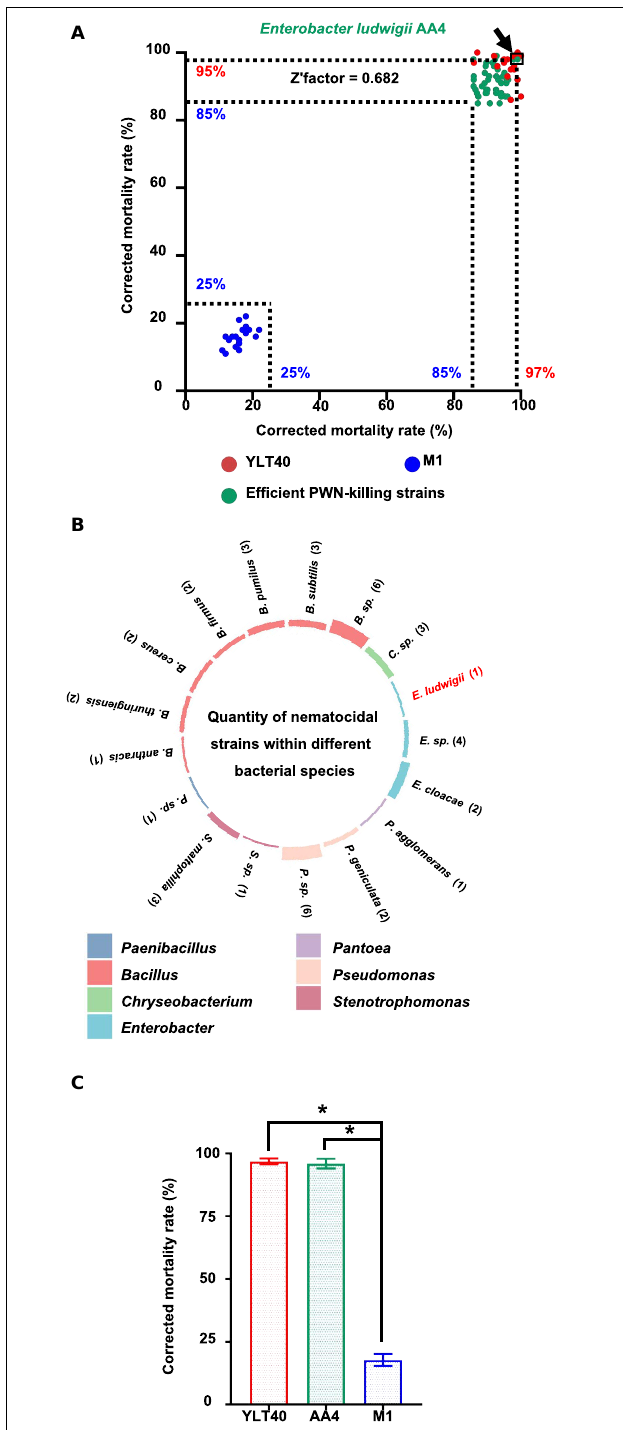
FIGURE 1 | Screening and taxonomy of the nematocidal bacterial strains against pine wood nematodes (PWNs). (A) Screening of strong PWN-killing bacterial strains against Bursaphelenchus xylophilus . The green dots represent the 43 strong nematocidal strains causing the death of more than 85% of B. xylophilus treated with them, while the blue and red dots are bacterial cultures of Bacillus pumilus YLT40 and Paenibacillus polymyxa M-1